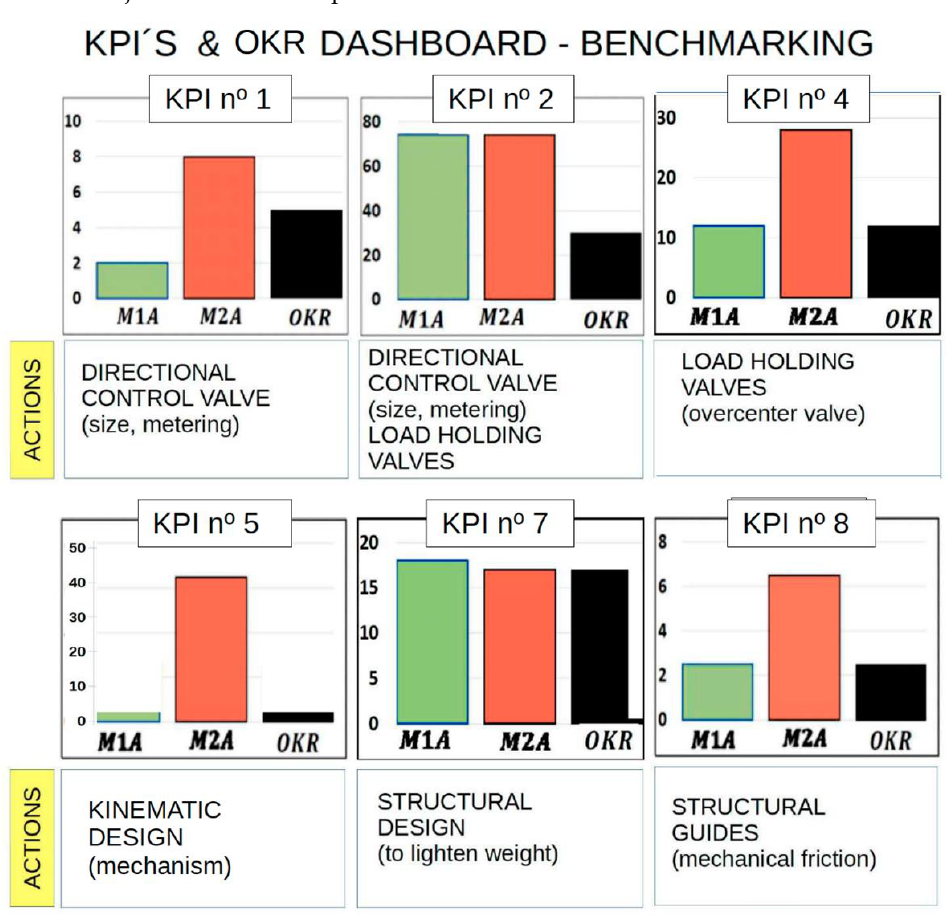
Figure 13. Dashboard of the KPIs (key performance indicators) and OKR (objectives and key re- sults).